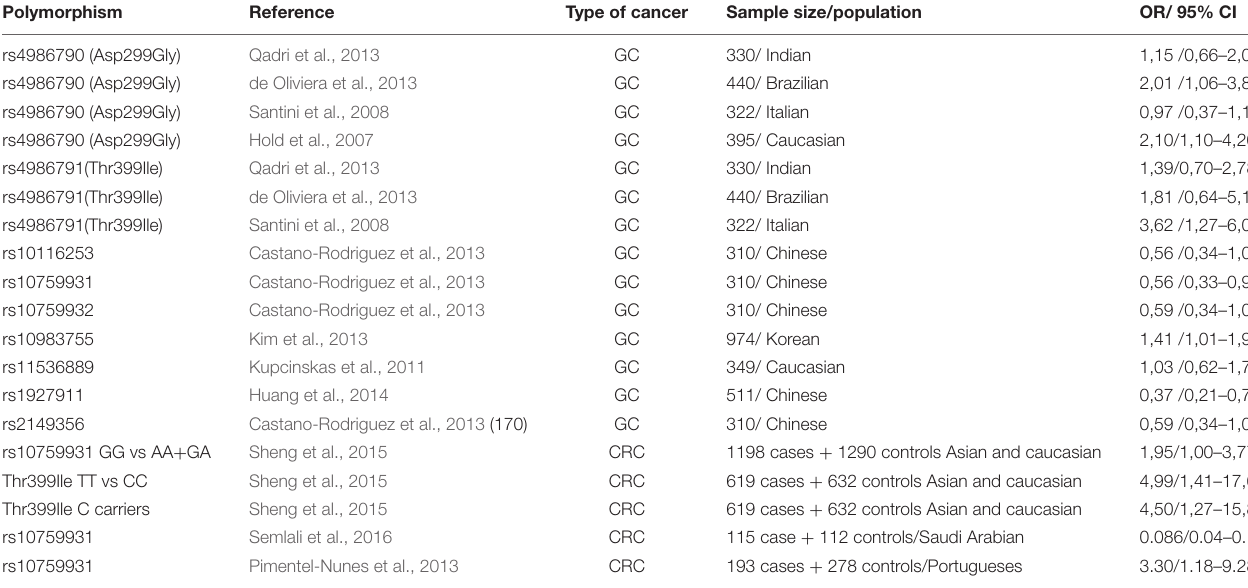
GS, Gastric cancer; CRC, Colorectal cancer; OR, Odds ratio; NS, Not specified; CI, confidence intervals.